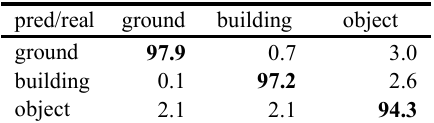
Table 5: Confusion matrix (% recall ) for 3 classes, 500 hidden layers and weighted.